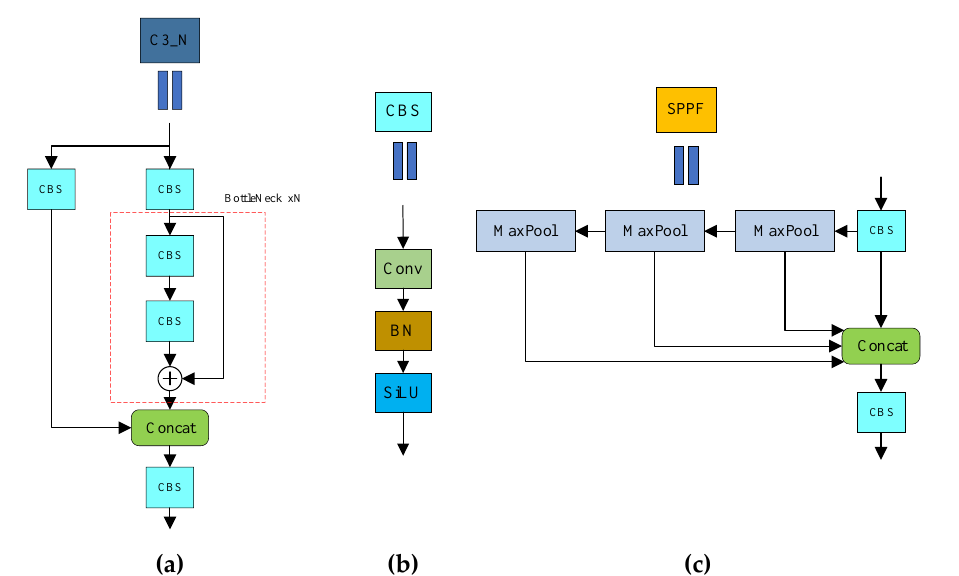
Figure 1. Structure of C3, CBS, and SPPF modules. ( a ) C3; ( b ) CBS; ( c ) SPPF.